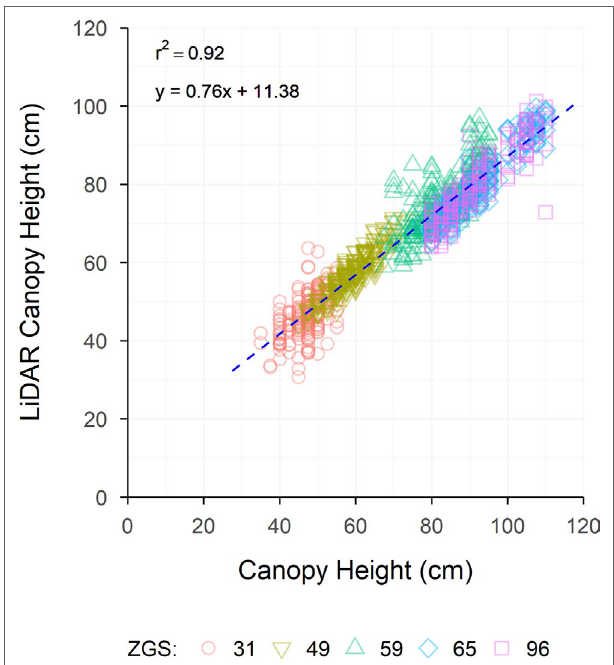
FIGURE 6 | The relationship between LiDAR Canopy Height and Canopy Height for all sample times measured at Roseworthy. Dashed lines indicate the line of best fit, coloured shapes indicate measurements collected at Zadoks growth scales (ZGS) as follows, red circles at ZGS 31, yellow triangles at ZGS 49, green triangles at ZGS 59, blue diamonds at ZGS 65 and pink squares at ZGS 90.